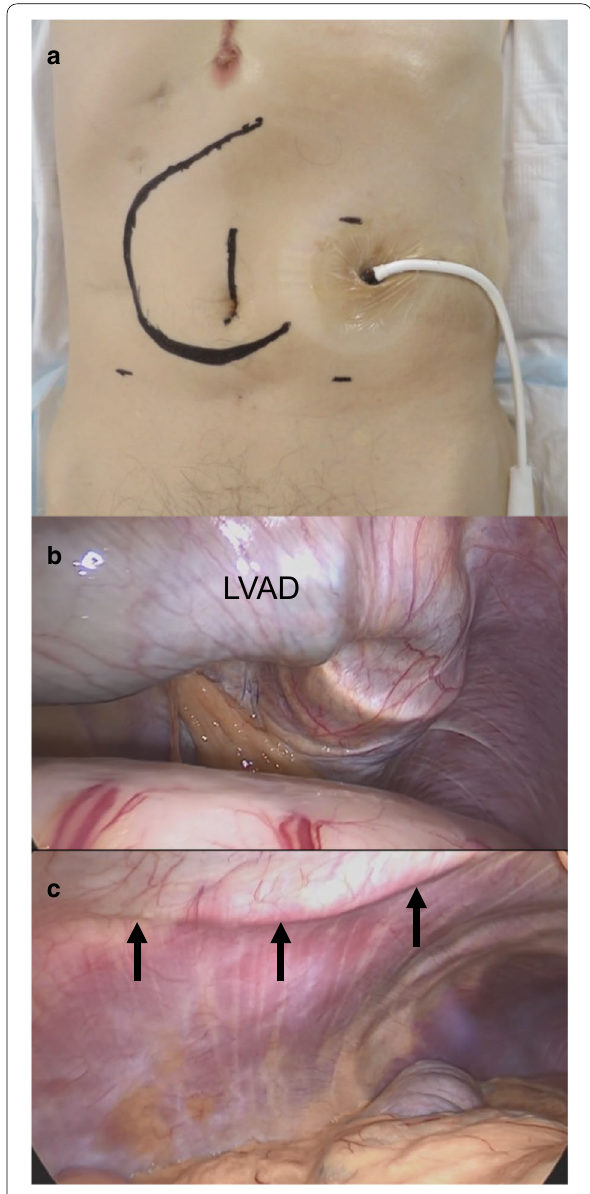
Fig. 2 Preoperative marking ( a ) and laparoscopic view of the LVAD and the driveline ( b , c ). a The marking shows the driveline, the trocar positions and the small incision. b No adhesions were observed in the abdominal cavity even underneath the LVAD pump. c The driveline (black arrow) was relatively close to the midline and away from the trocar insertion positions of the right